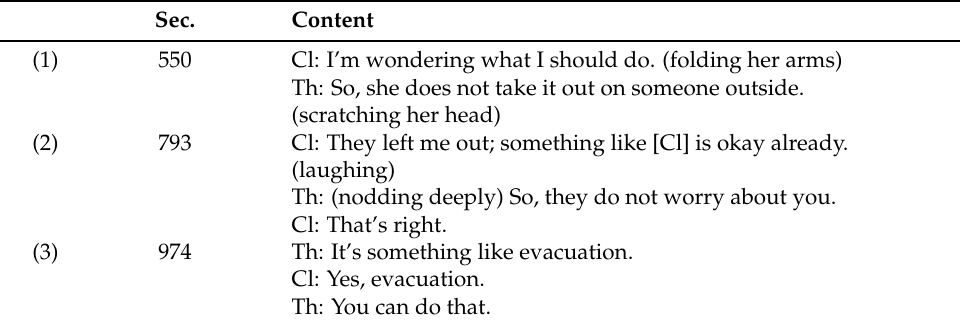
Table 3. Contents of interactions in the second dialogue highlighted by the analysis (Therapist: Th, Client: